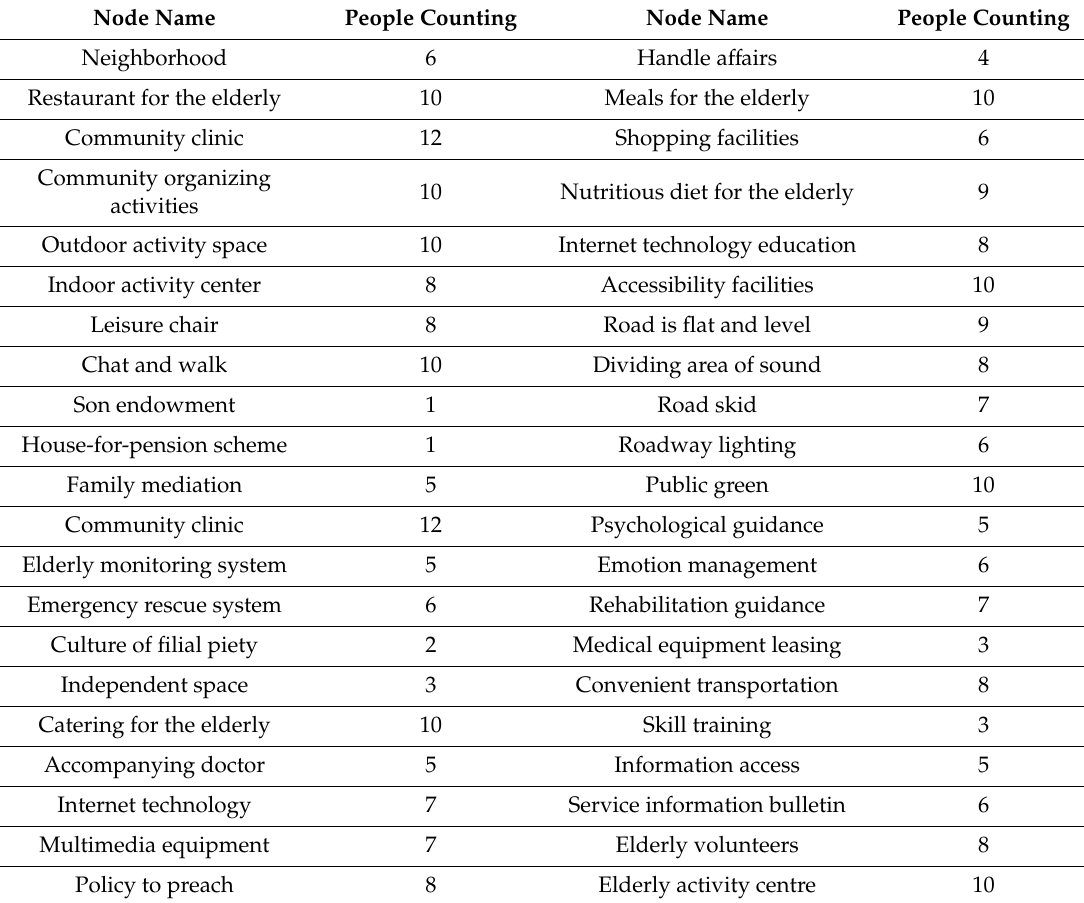
Table 3. Free node information of interview